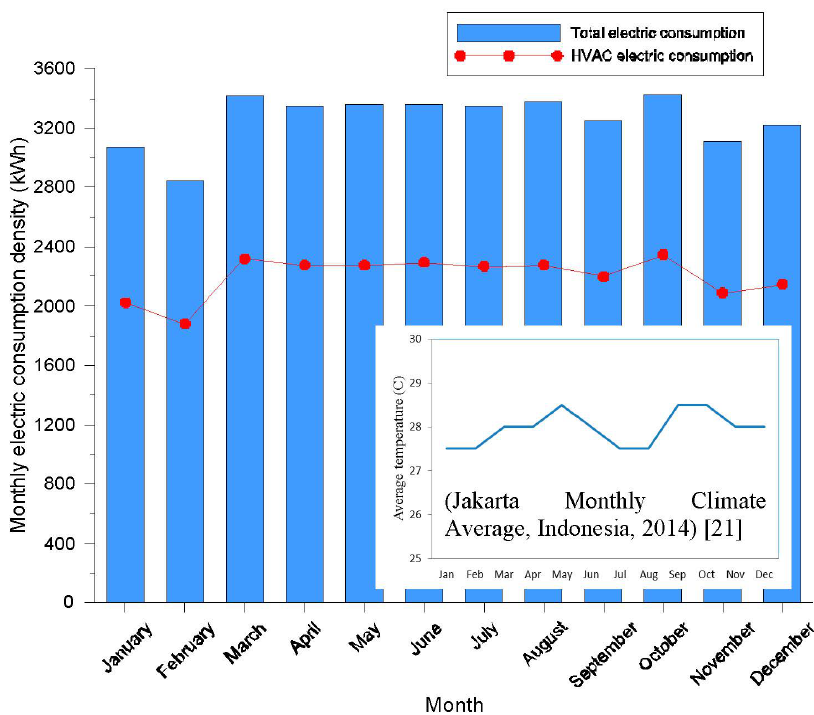
Figure 5. Monthly and HVAC energy consumption of the baseline case (facing